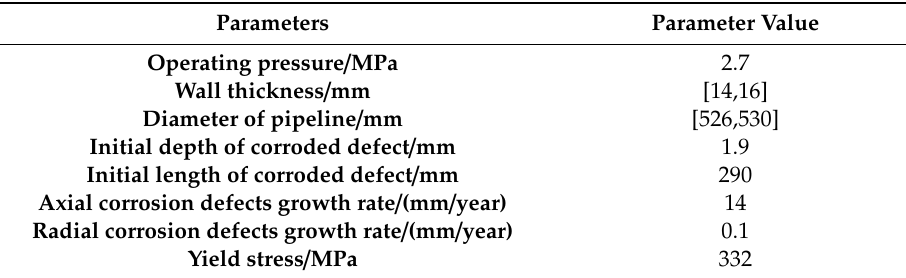
Table 3. Basic parameters of corroded pipeline.